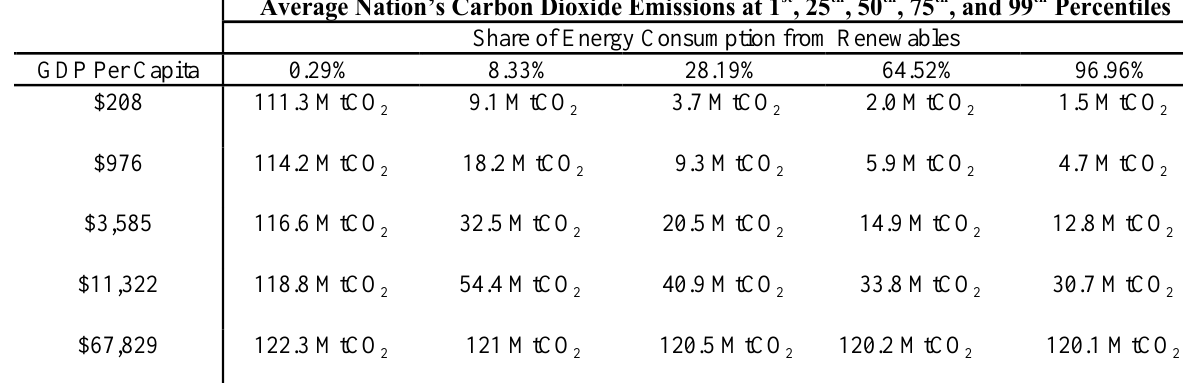
Table 4. Nation’s Carbon Emissions Expected at 2st, 25 th , 50 th , 75 th , and 99 th Percentile Using World